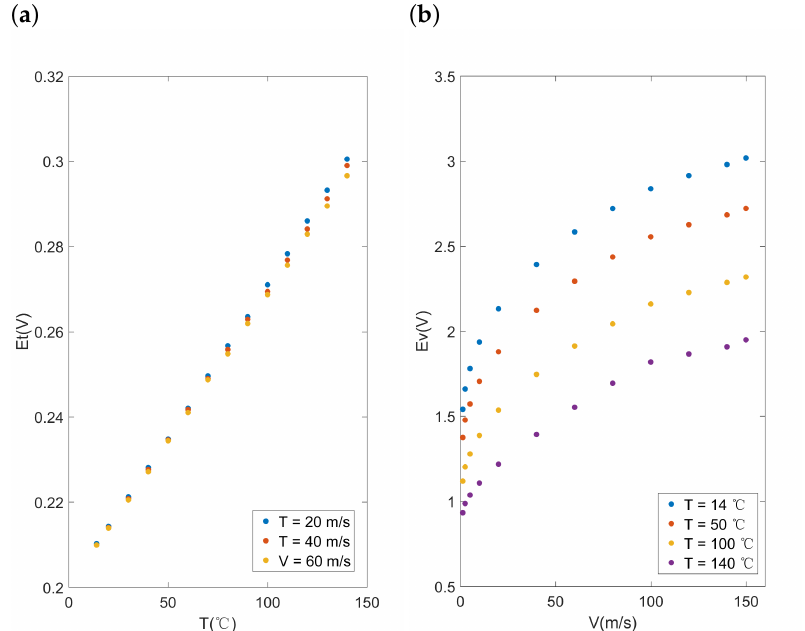
Figure 3. Calibration curves: ( a ) Temperature sensor response and ( b ) velocity sensor